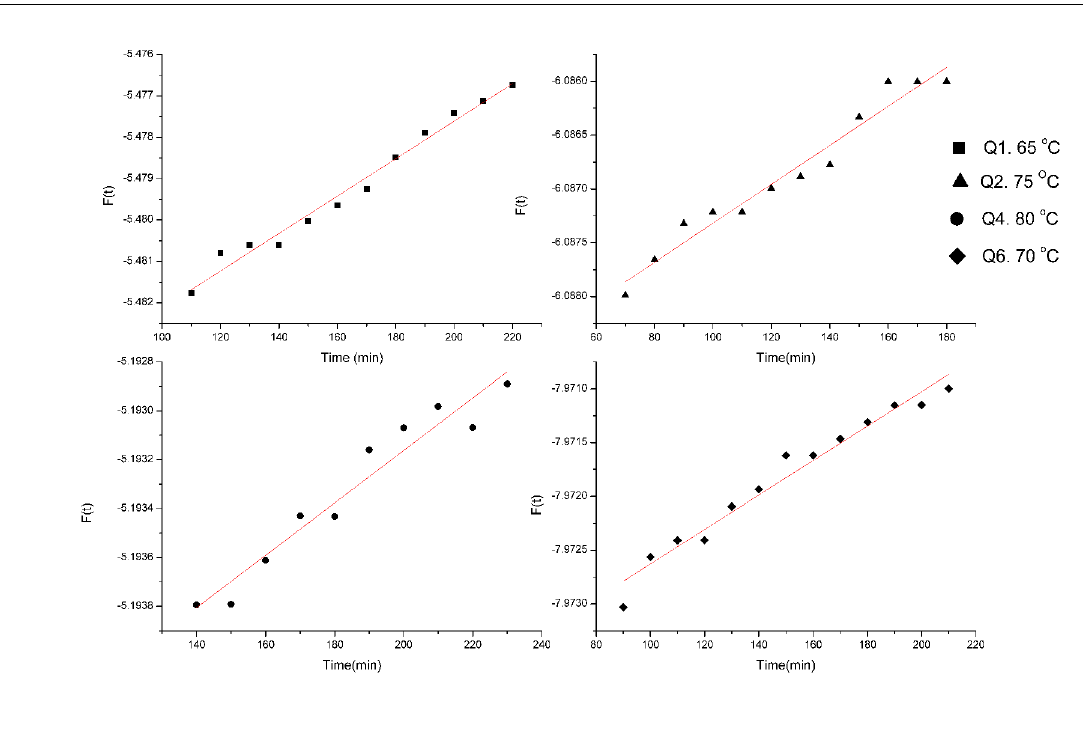
Figure 12. Straight lines obtained for four of the experiments using crystalline quartz, in the integral